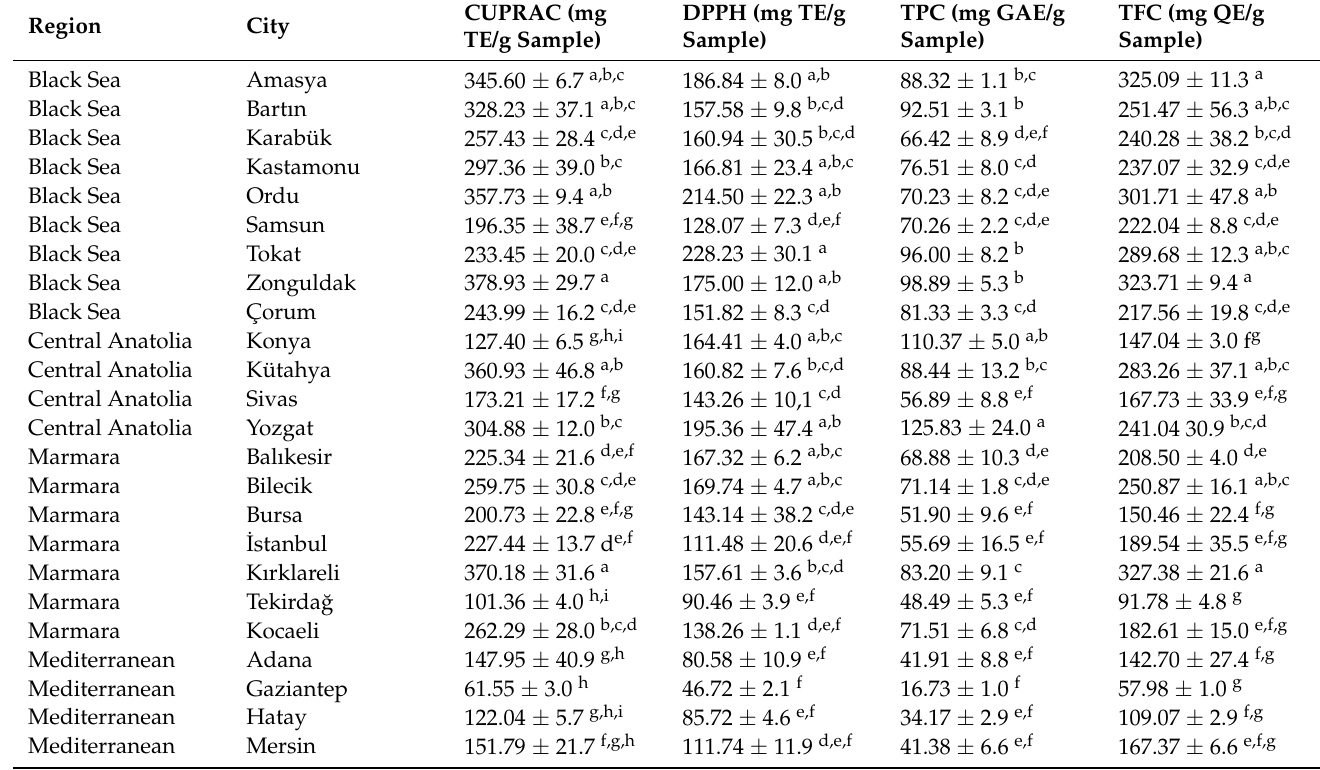
Table 2. Total phenolic and flavonoid contents and antioxidant capacity results (CUPRAC and DPPH) of ethanolic extracts of Anatolian propolis samples (data are expressed as mg/g of the crude propolis sample).